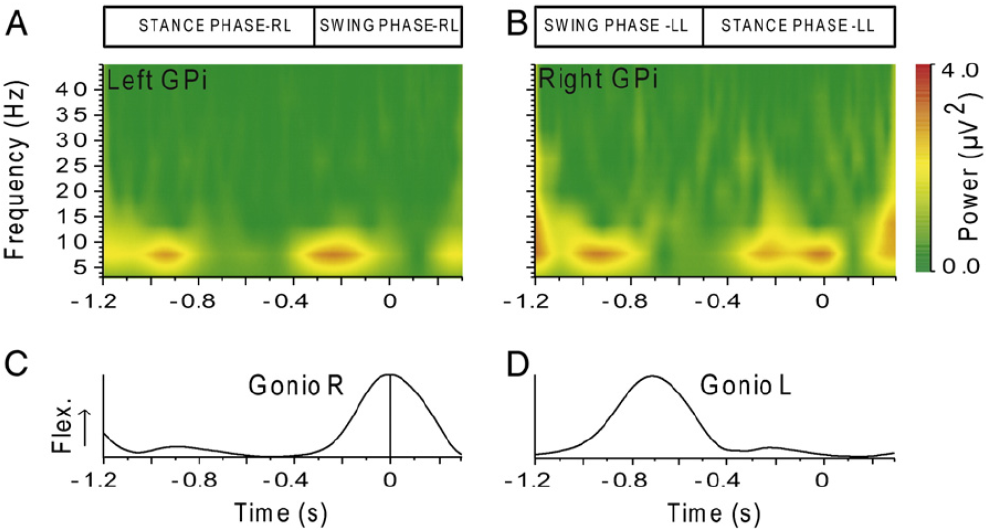
Figure 8. Time-frequency plots (wavelet transformation) of LFP oscillations during gait cycle. Upper row ( A ) and ( B ): analyzed electrode pair. The right electrode pair is on the right side. ( C ) and ( D ): goniometer traces. Modulation of LFPs occurs in the 6–11 Hz frequency range. In this frequency band, amplitudes are upregulated during the early stance phase and swing phase of the contralateral leg. LL: left leg; RL: right leg; Gonio: goniometer; Flex: flexion. This figure is reproduced with permission from [142]; Copyright Elsevier,